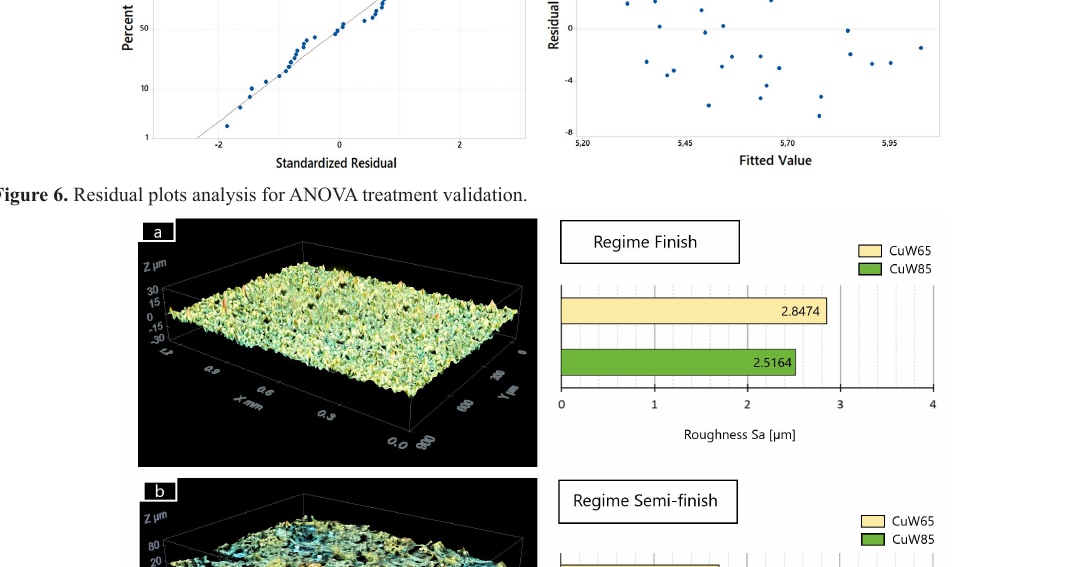
Figure 7. 3D topography and WC-Co surface roughness Sa results for ED-Machining under (a) finish (i (i = 11 A, t = 56 µs) and (c) rough (i e e